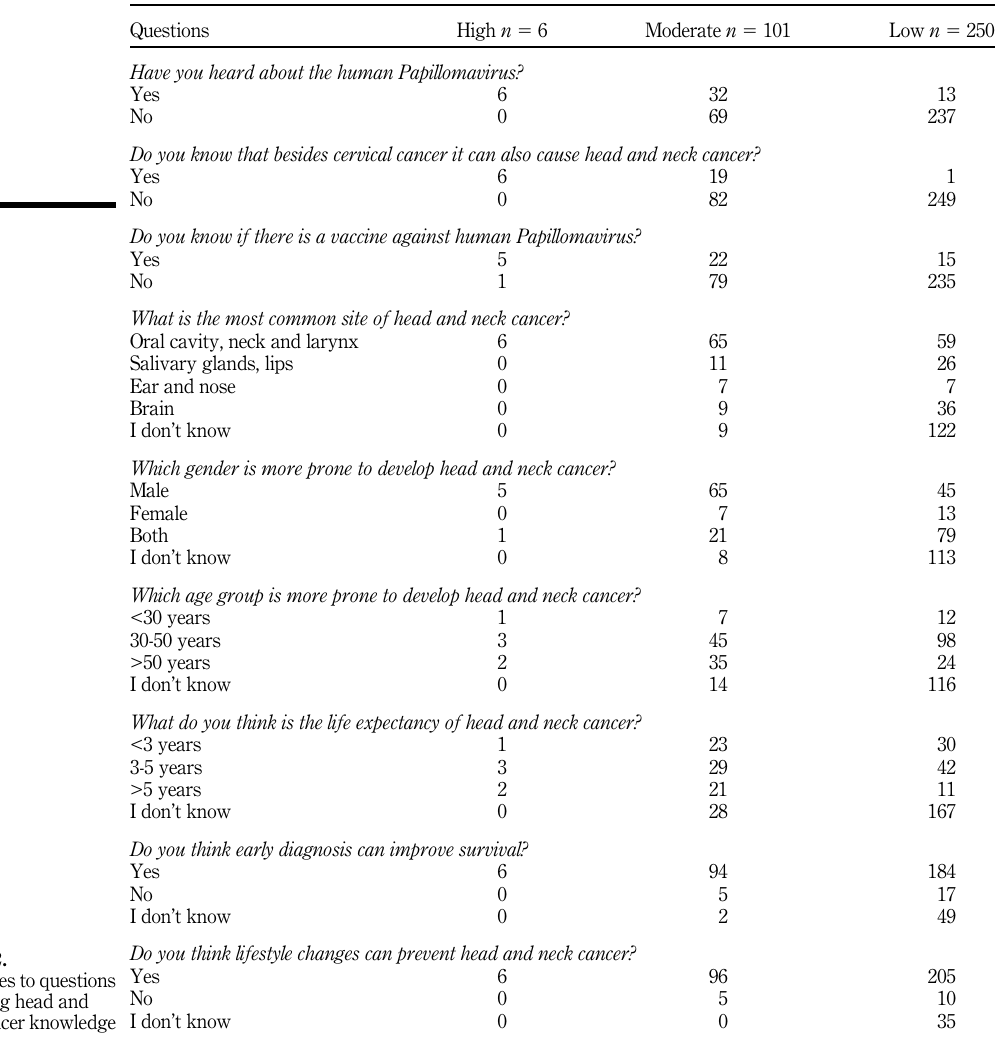
Table 2. Responses to questions regarding head and neck cancer